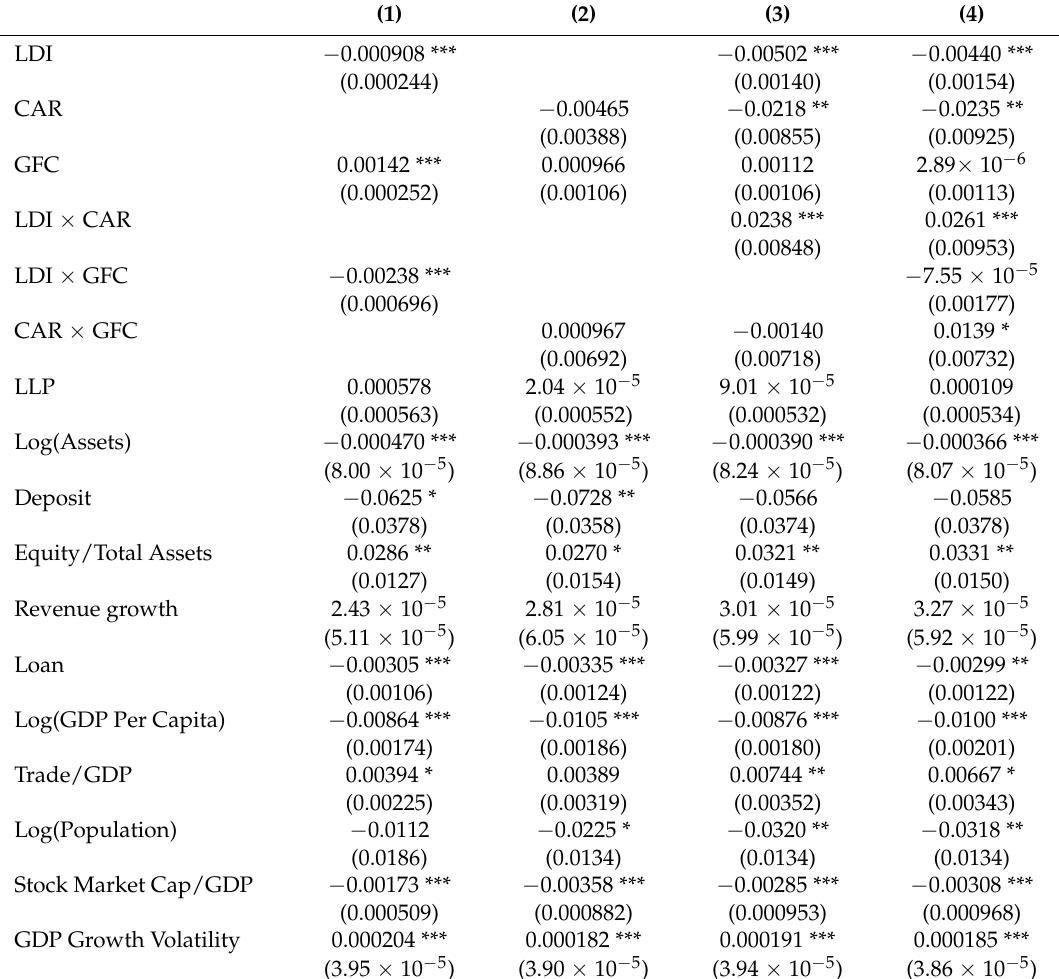
Table 4. Effect of deposit insurance and capital adequacy on bank risk—earning